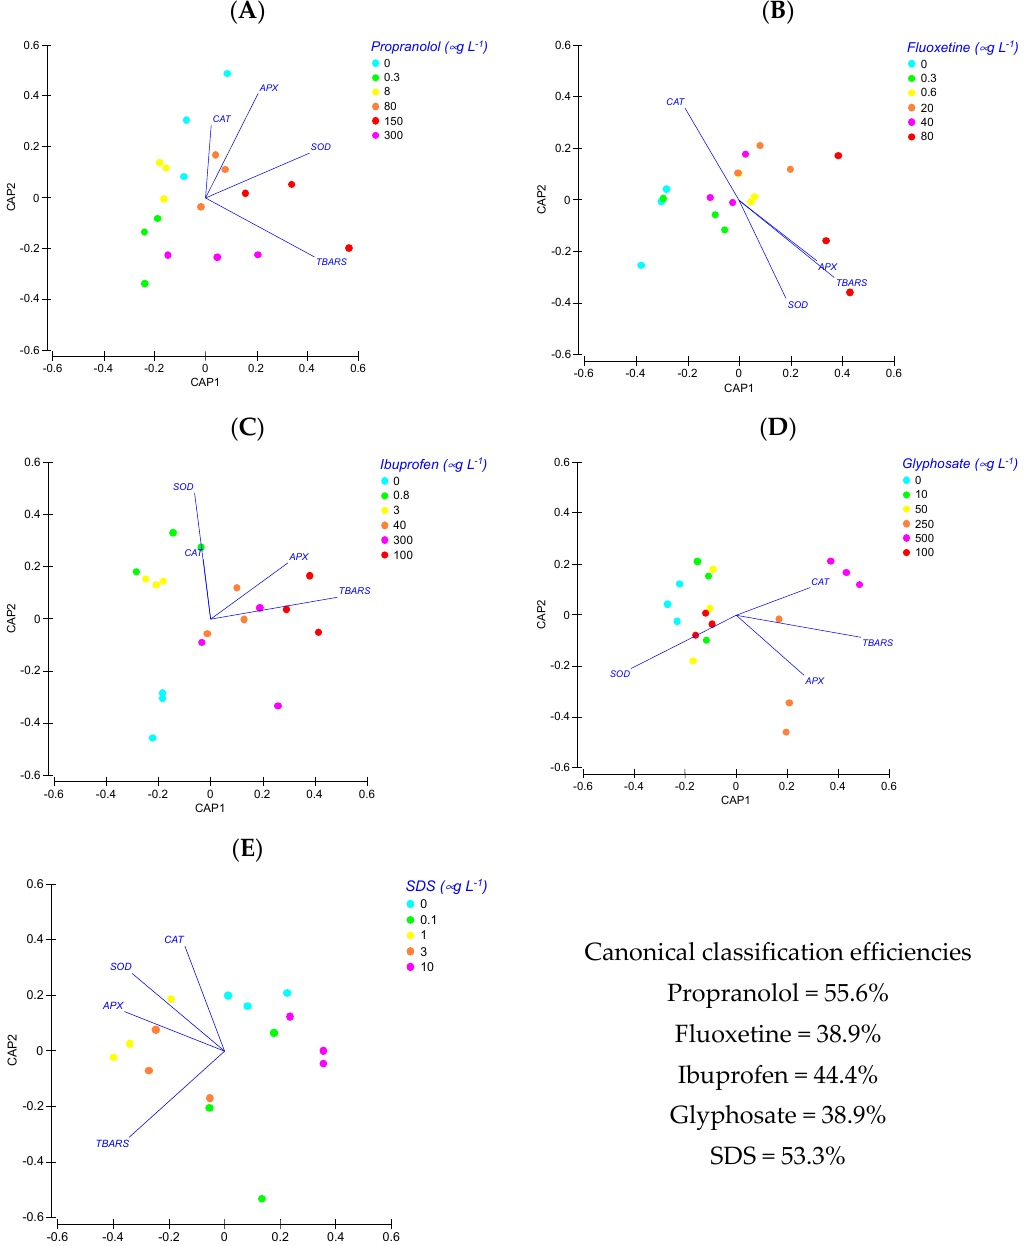
Figure 1. Canonical analysis of principal components plots of the diatom cells exposed to propranolol ( A ), fluoxetine ( B ), Ibuprofen ( C ), glyphosate ( D ), and SDS ( E ) at different exogenous concentrations, having the biomarker values as classifying variables. Data sources are available in Table 1.